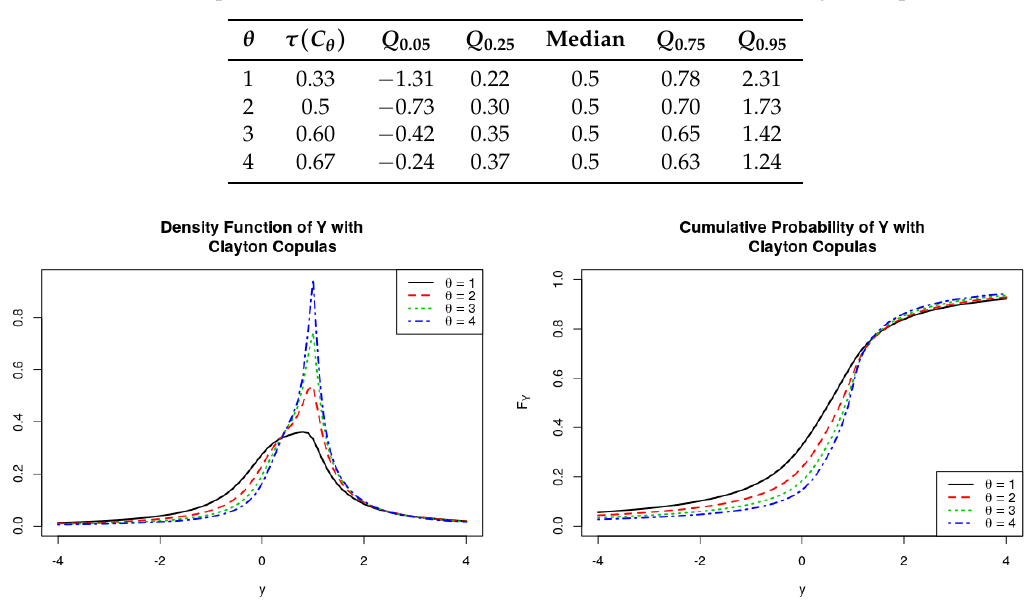
, where ( X 1 , X 2 ) follows Clayton X 2